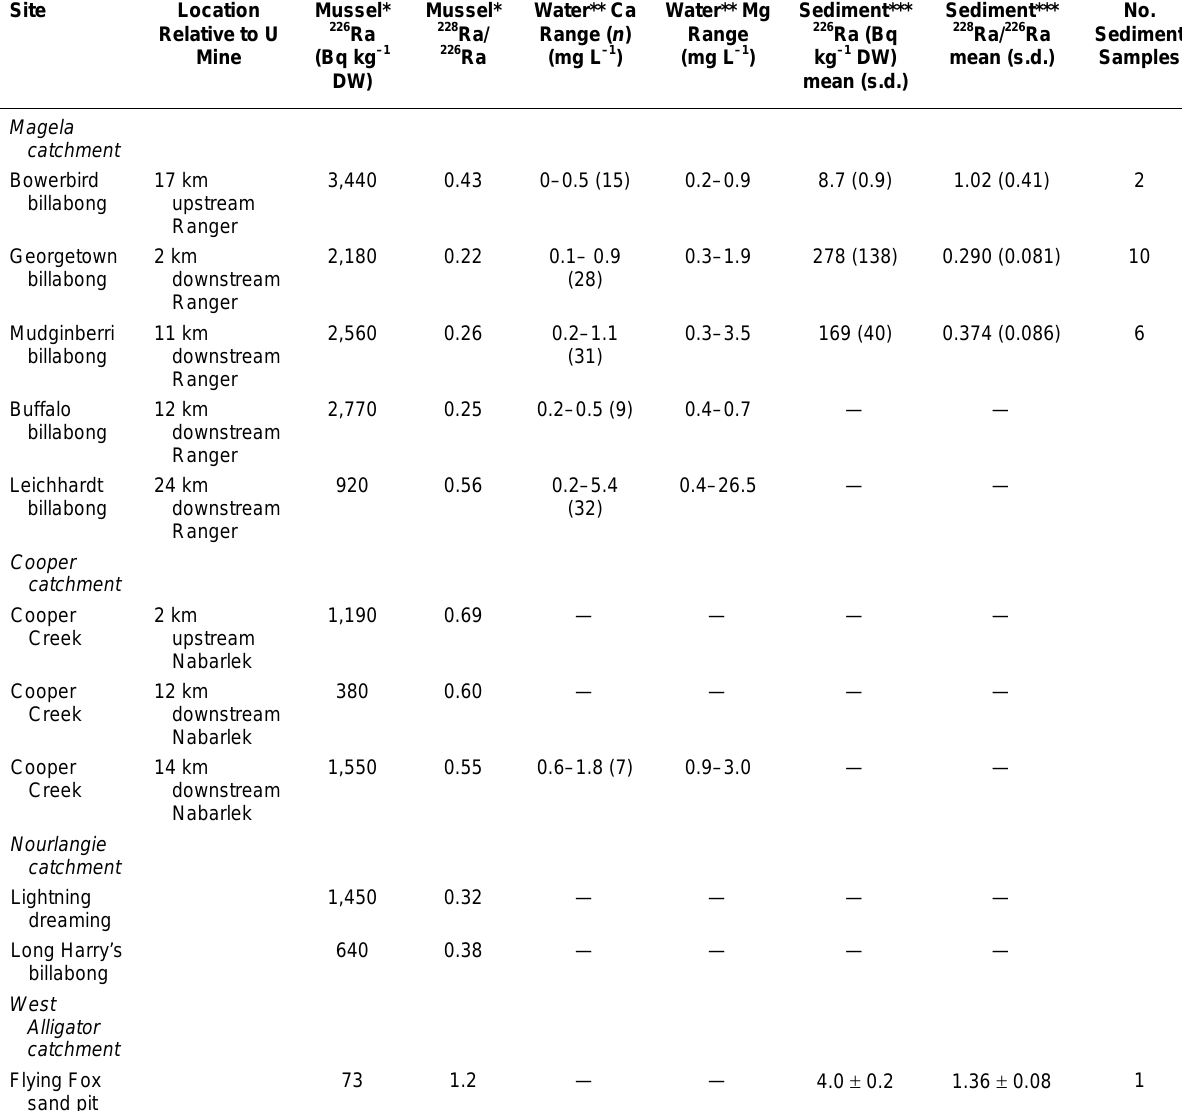
Concentrations of 226 Ra and 228 Ra/ 226 Ra Activity Ratios for V. angasi Flesh Samples Collected from Various Locations in the ARR, 1983, Together with Data for Ca and Mg Concentration in Billabong Water[30], and 226 Ra Concentration and 228 Ra/ 226 Ra Activity Ratios for Billabong Surface Sediment